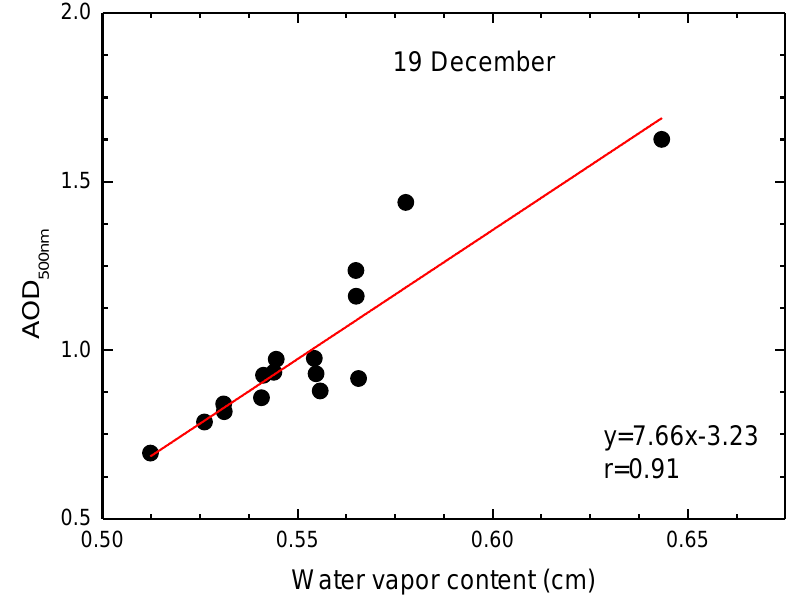
Figure 6. Scattergram of the AOD 500nm vs. CWV on 19 December in Beijing.